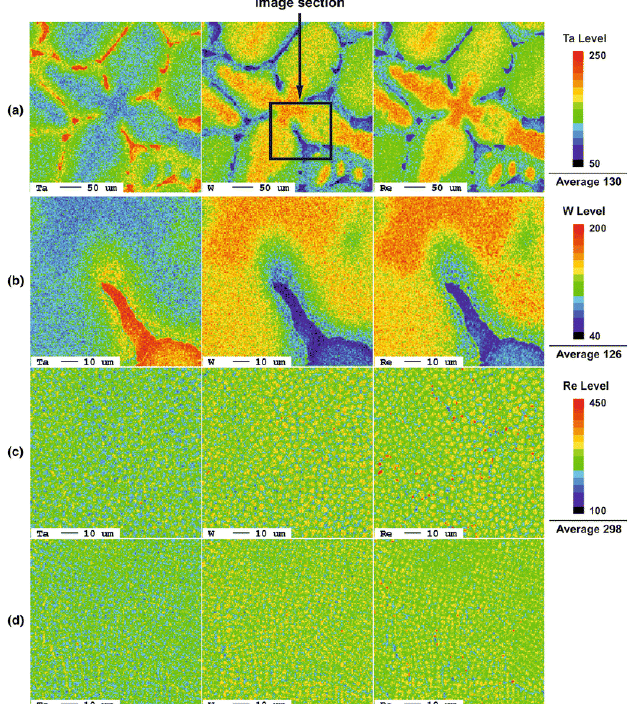
Figure 22. Qualitative microprobe mappings (horizontal cross section) of Ta, W, and Re: ( a ) as-cast sample analyzed with a spot size of 2 µ m; ( b ) Magnification of ( a ) (spot size 0.5 µ m); ( c ) EB-PBF sample (P = 510 W, v = 6000 mm/s, line offset = 0.03 mm) (spot size 0.5 µ m); ( d ) EB-PBF sample (P = 180 W, v = 300 mm/s, line offset = 0.1 mm) (spot size 0.5 µ m) [69].